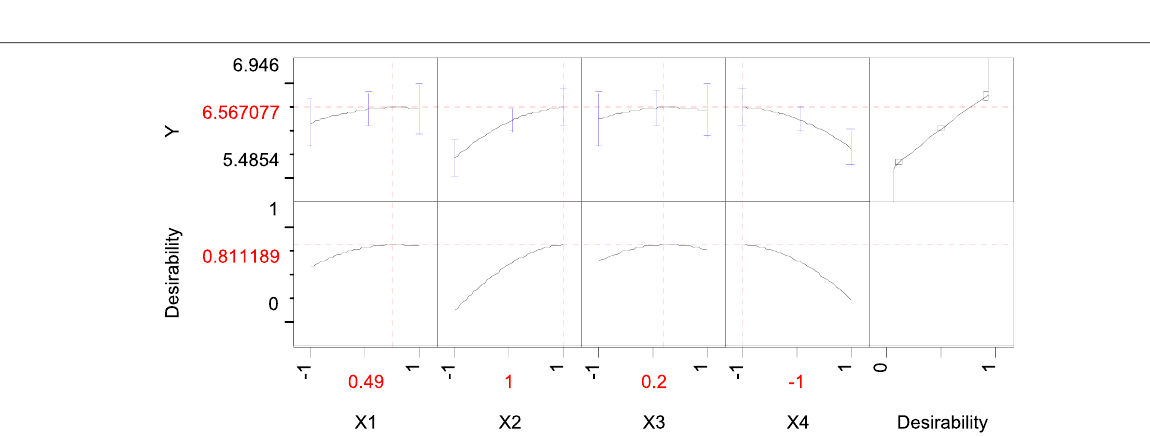
1) of studied four variables pH, −